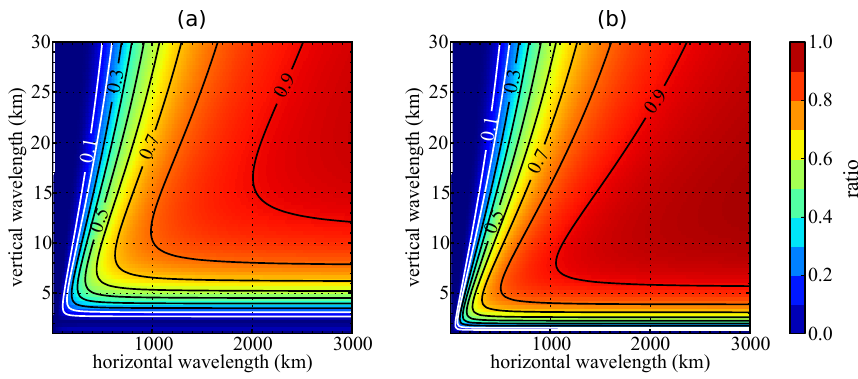
Figure 7. Two-dimensional sensitivity function for GWMF of (a) SABER and (b)